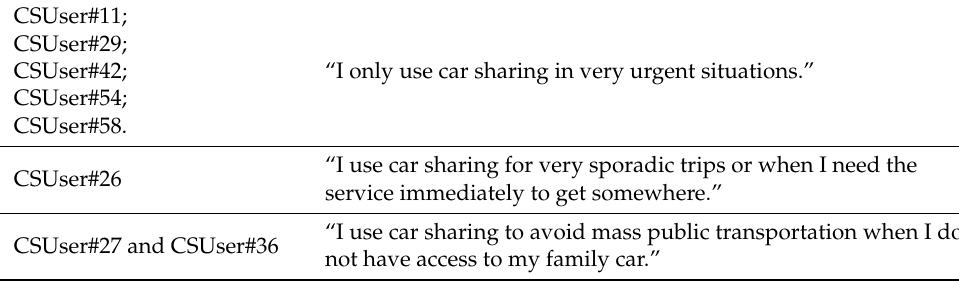
Table 4. Behaviour of participants that has decreased in car sharing